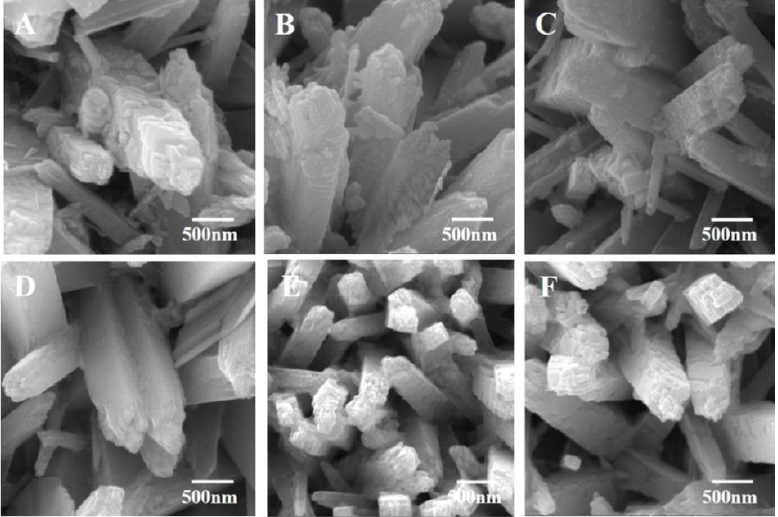
Figure 4. The SEM image of R-WO 3 /R-TiO 2 /CC was prepared by electrochemical reduction of different potentials ( A ) − 1.0 V; ( B ) − 1.2 V; ( C ) − 1.4 V; ( D ) − 1.6 V; ( E ) − 1.8 V; ( F ) − 2.0 V.